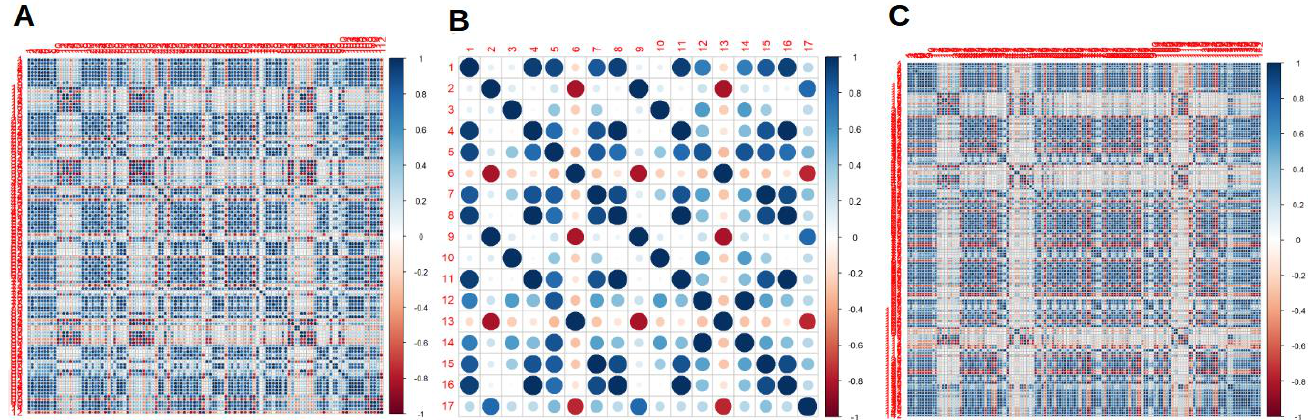
Figure 1. Cross correlation matrixes for radiomics features (RaF) for scanner 1 ( A ), scanner 2 ( B ) and both the scanner considered together ( C ).